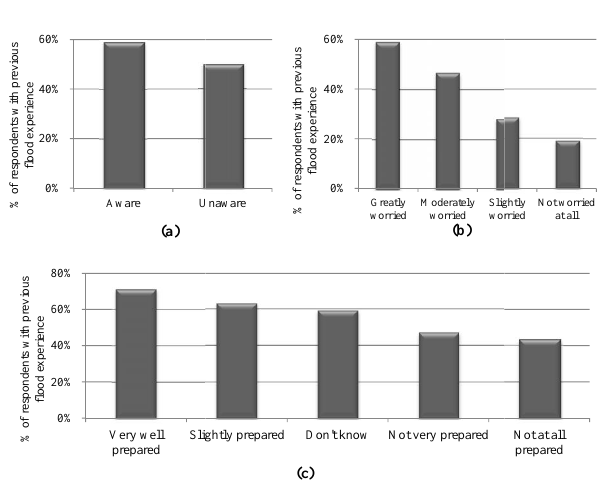
Fig. 3. Influence of previous flood experience on (a) awareness, (b) worry and (c) preparedness